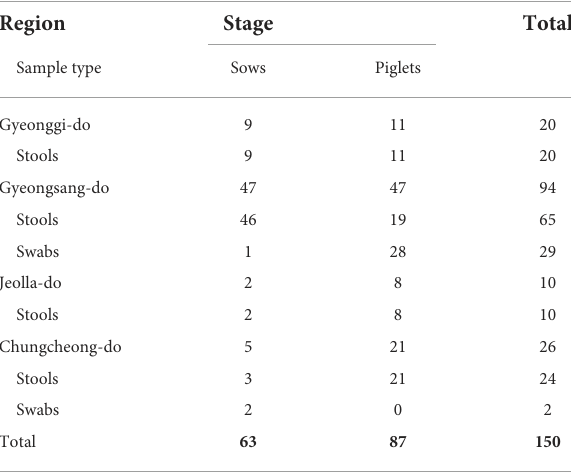
TABLE 1 Stages and sample types of 150 pigs at a pig farm in the Republic of